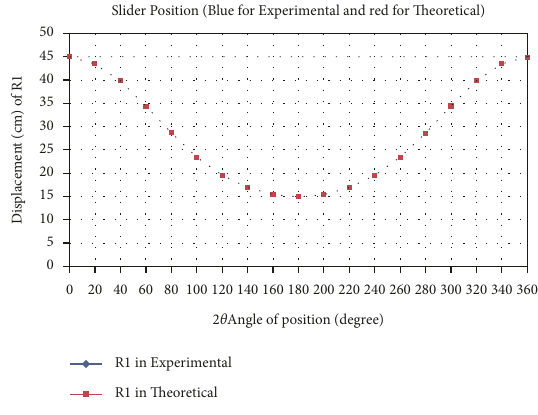
Figure 10: AC displacement against θ